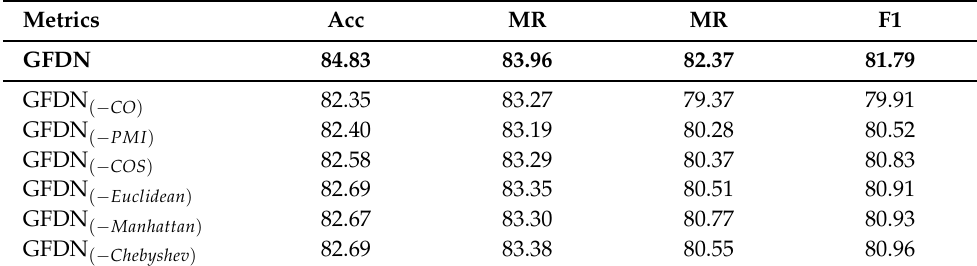
Table 7. Graph ablation experiment results on dataset CAIL-small.